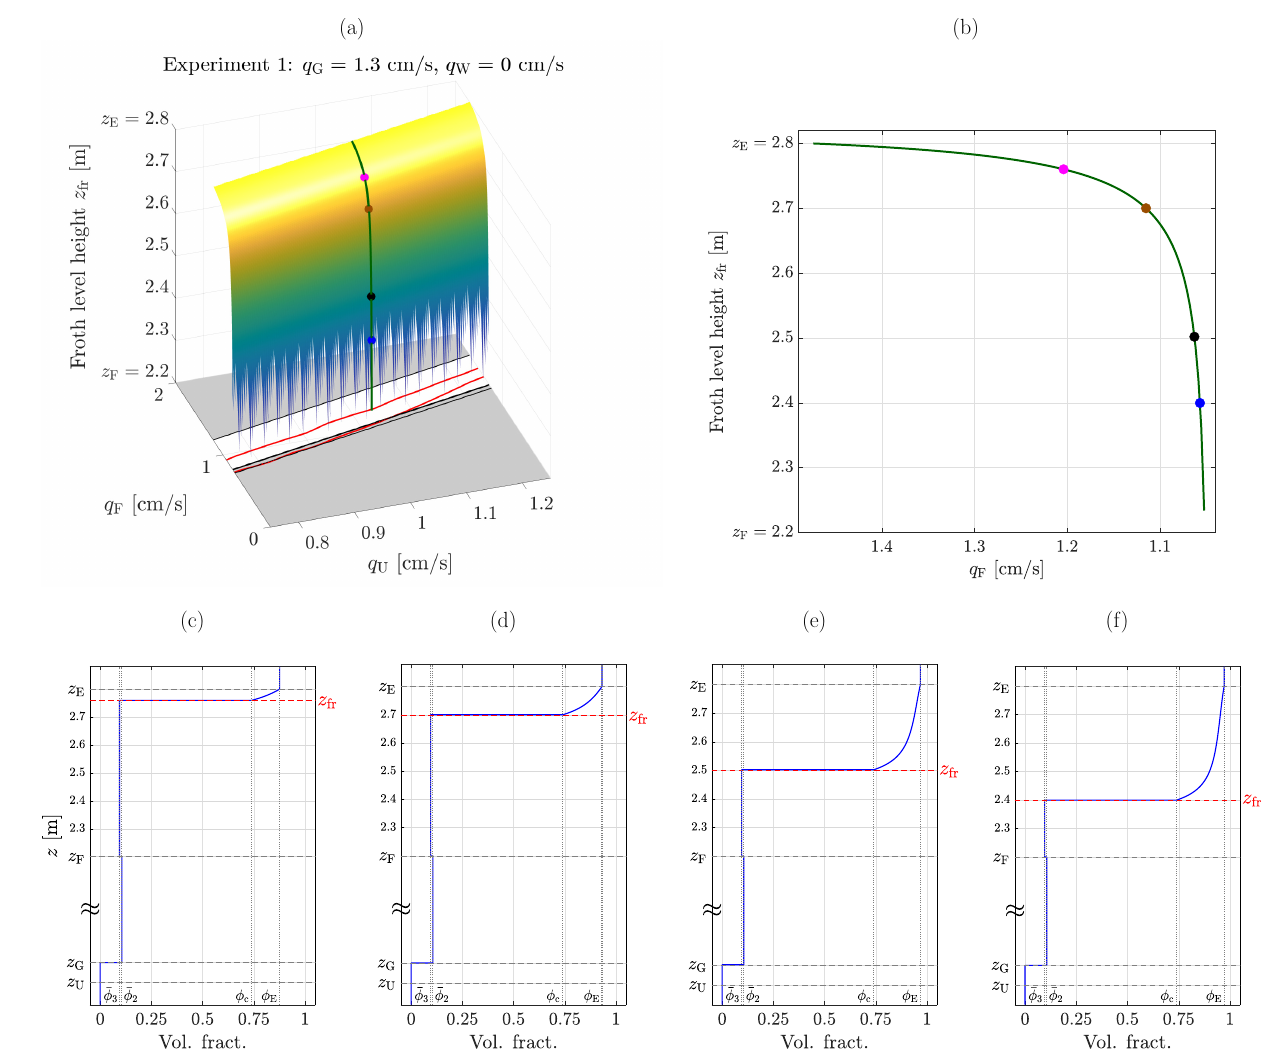
Figure 11. Experiment 1: Example of the use of the operating charts in Figures 9 and 10. ( a ) Enlarged view of Figure 9a. For a fixed value of q U = 1.02cm/s, the line ( q U , q F ) is marked in dark green, and four points with q F between 1.0568 and 1.2039cm/s inside the white region of the operating chart were chosen. ( b ) Cross section of the surface Z fr ( φ F , q G , q F , q U , q W ) for q U = 1.02cm/s (the q F -axis is oriented in decreasing order for ease of comparison with plot ( a )). ( c – f ) Steady states for the gas phase obtained with the points ( q U , q F ) marked in plots ( a , b ). The values used in each figure are ( c ) q F = 1.2039cm/s, ( d ) q F = 1.1150cm/s, ( e ) q F = 1.0628cm/s and ( f ) q F =